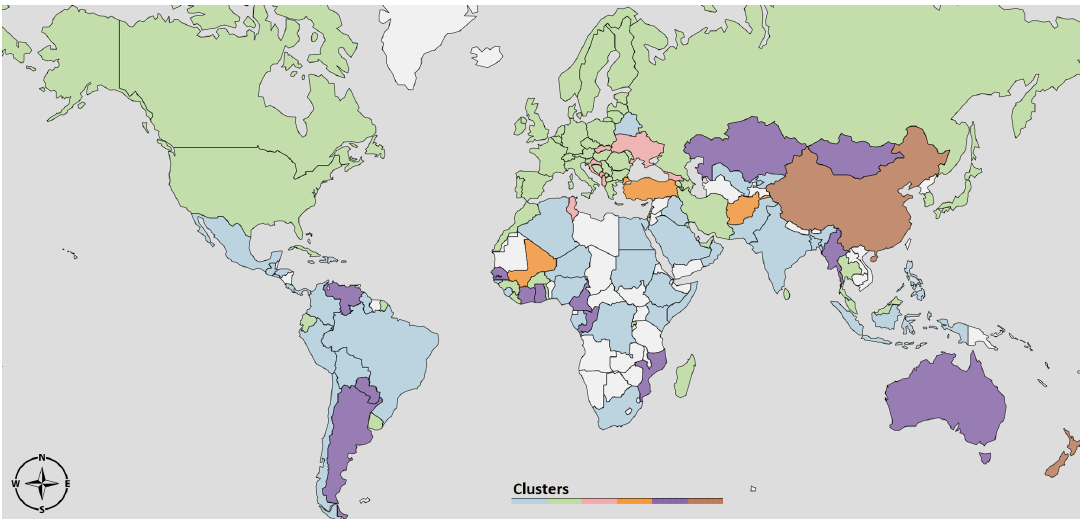
Figure 6. Visualization on a world map of clusters obtained from the dissimilarities of the vectors containing the fitted model parameters ν 1 , ν 2 , and ν 3